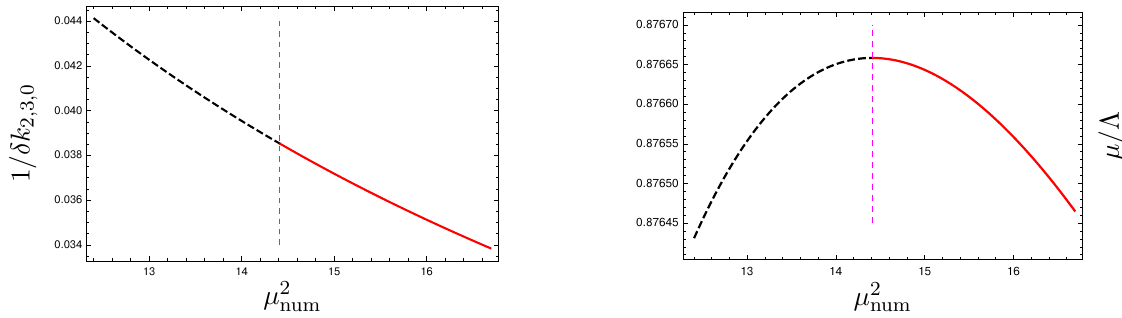
Figure 32 . Variation of parameters (6.43) of the critical Klebanov-Tseytlin black hole with µ num : while δk 2 , 3 , 0 monotonically increases with µ num (left panel), µ/ Λ (right panel) reaches a maximum at µ num = µ num , max (6.44), represented by the vertical dashed magenta